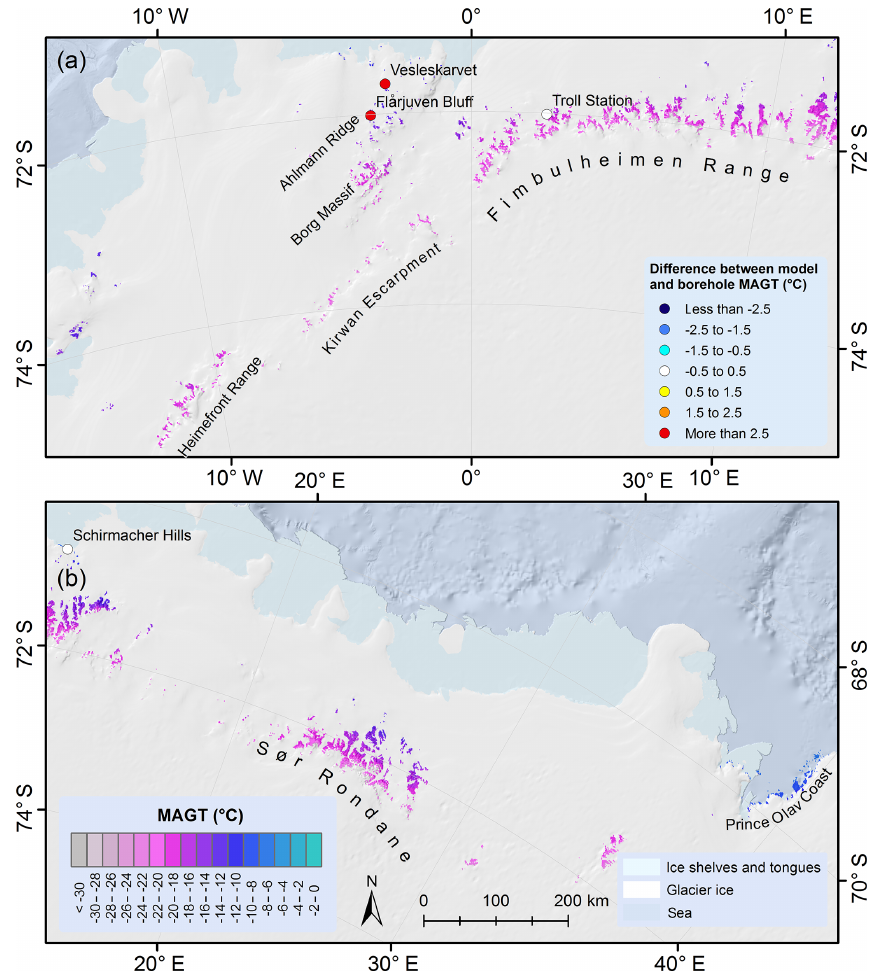
Figure 3. Permafrost temperature maps of Queen Maud Land and differences between borehole and modelled MAGT. Legends, scale and north arrow are valid for both panels. See Fig. 1 for location of panels (a) and (b)